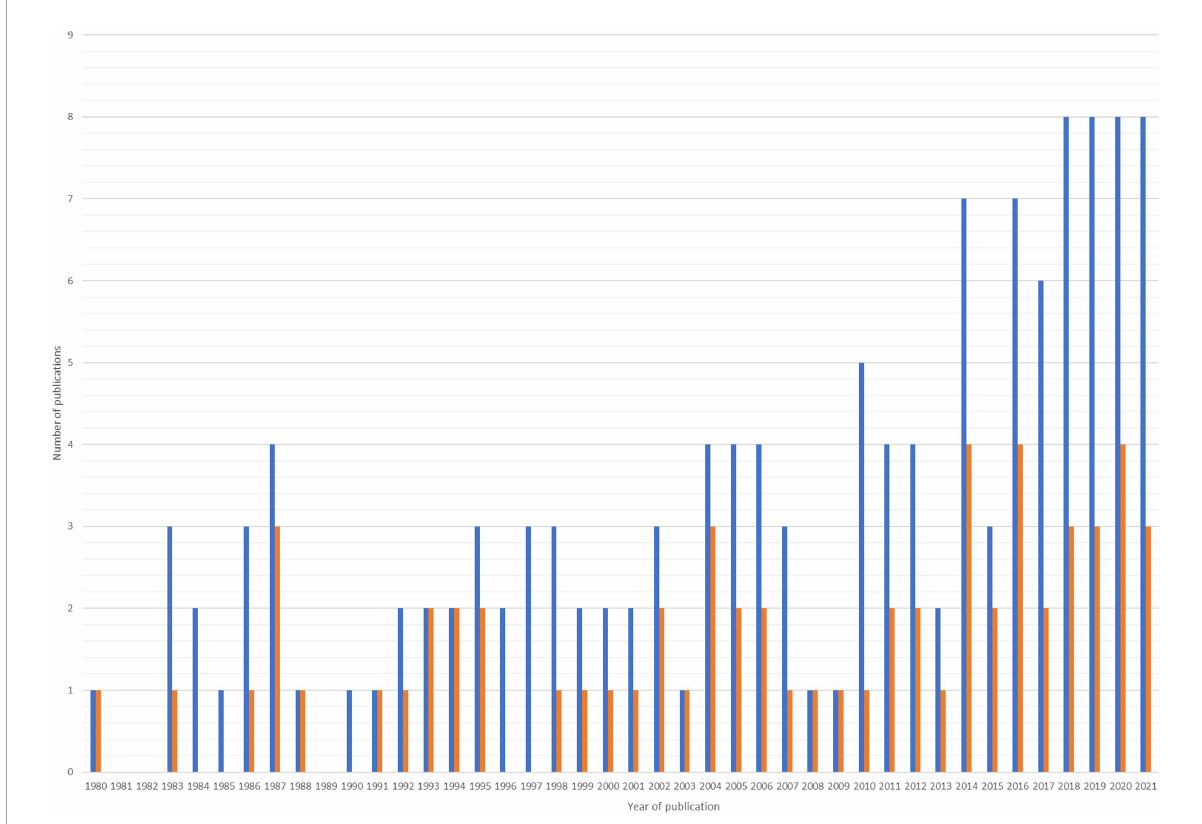
FIGURE3 Publications by year. Blue are publications in a certain year and orange are publications with incorrect sonographic images according to the Graf method. Only publications that were analyzed in this review were included in this